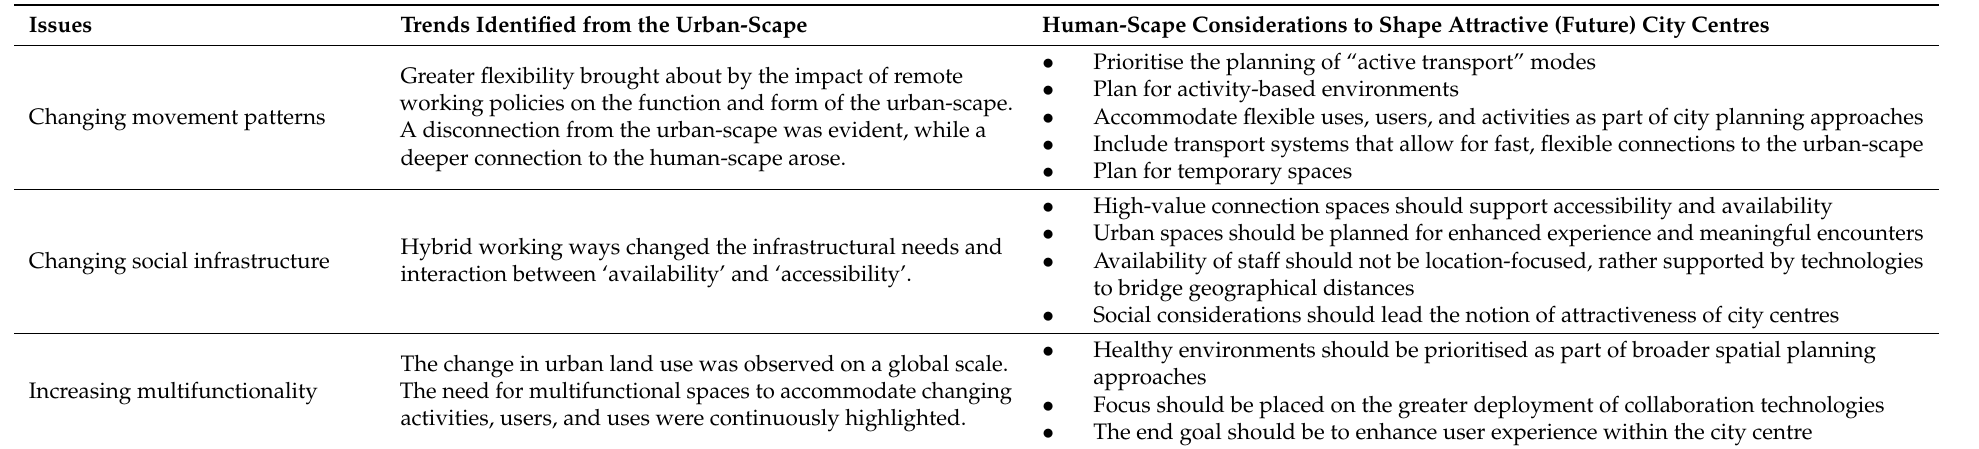
Table 3. Changing trends that will define future